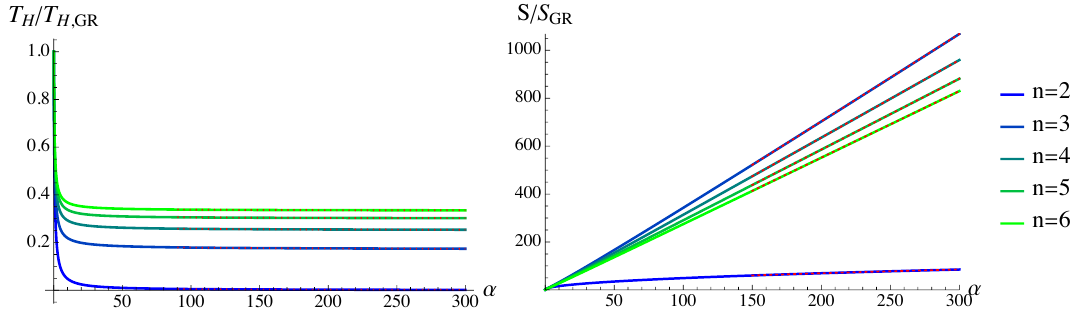
Figure 5 . Mass vs. α . Numerical results are plotted by solid curves for each dimension. Red dotted curves are the fitting curves in eq. (6.4) for n > 2 and eq. (6.7) for n = 2 .